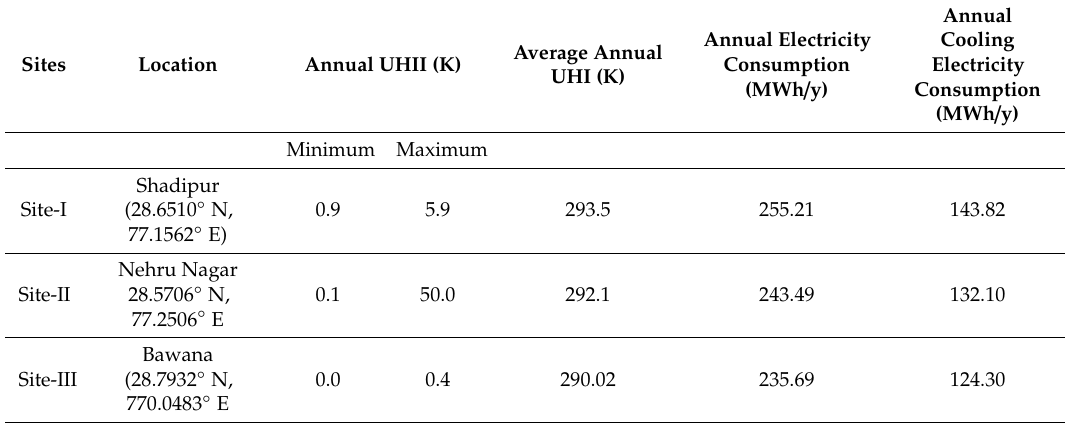
Table 5. Simulation sites and annual electricity consumption and cooling electricity consumption details.